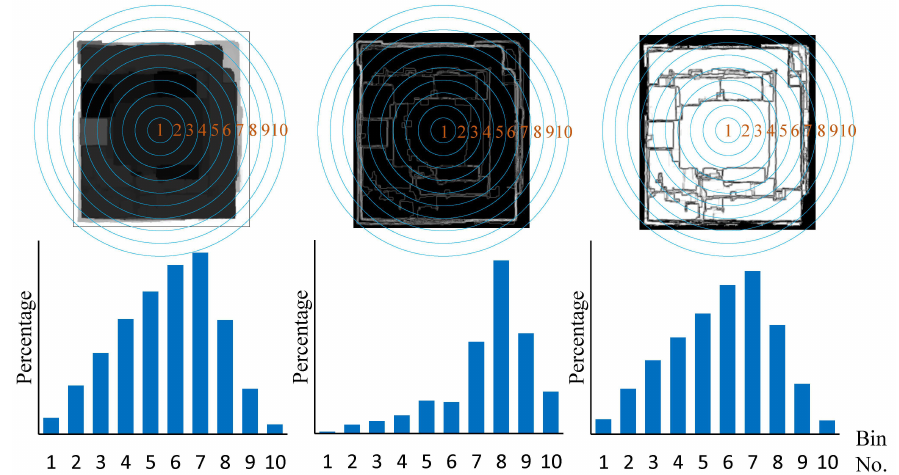
Figure 6. Results of the spatial histograms of height ( left ); edge ( middle ); and planarity features ( right ); Feature images ( top ) and corresponding spatial histograms of 10 bins ( bottom